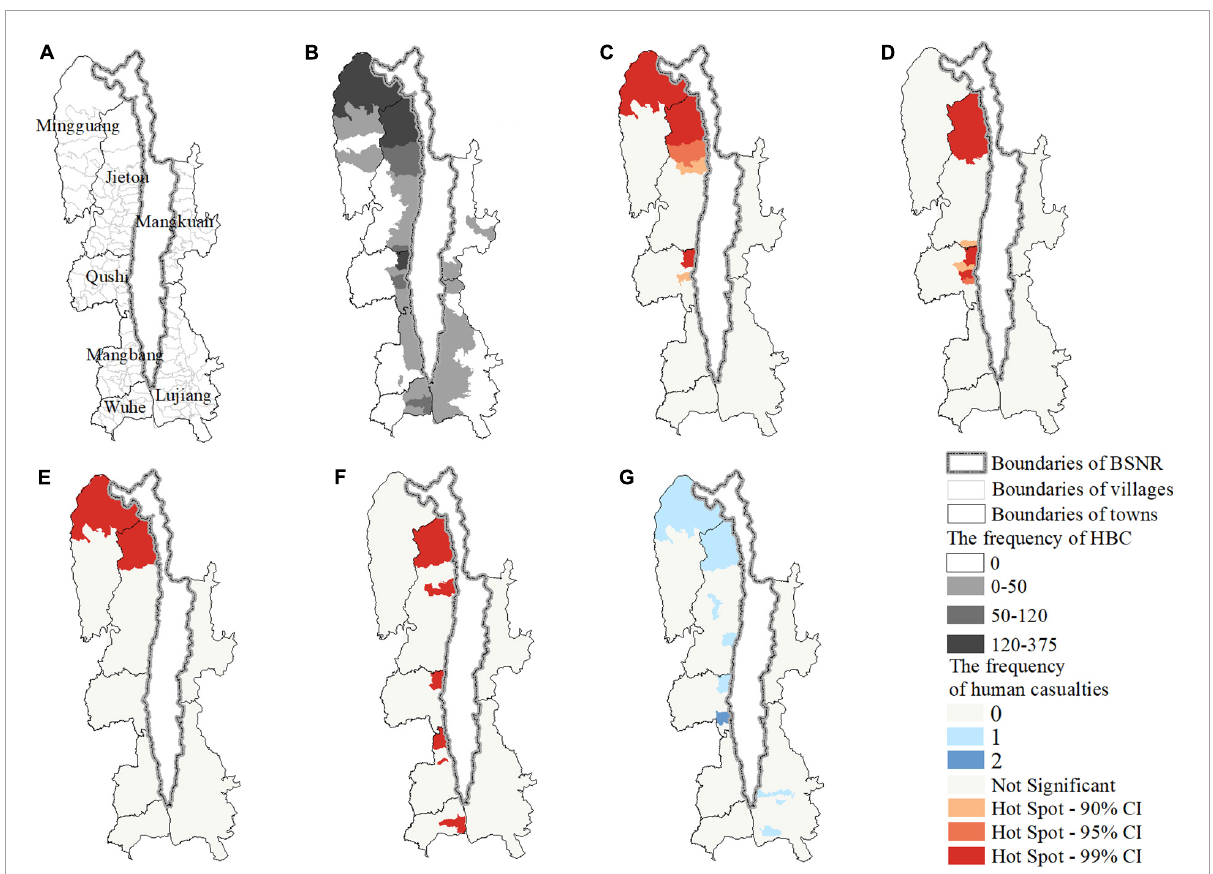
FIGURE2 Maps showing the study area (A) the townships and villages, (B) the villages experienced human-bear conflicts; and the hotspot of human-bear conflicts for (C) all types combined, (D) crop raiding; (E) livestock depredation, (F) beehive loss, and (G) the frequency of human casualties, between 2012 and